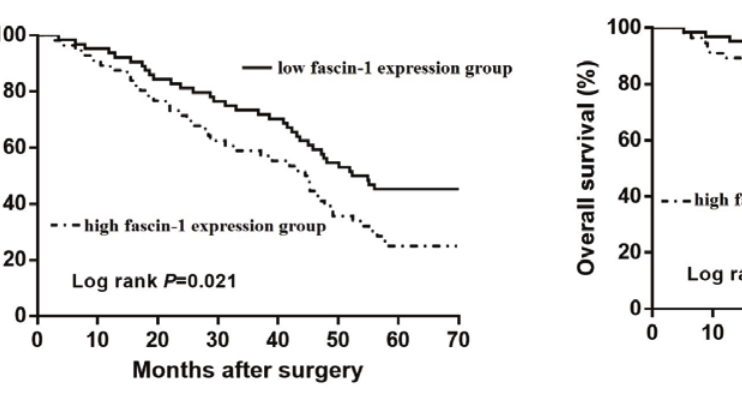
Figure 4: The fascin-1 protein expression status and progression- free survival of glioma patients. Table 2: Univariate and multivariate analyses for overall survival